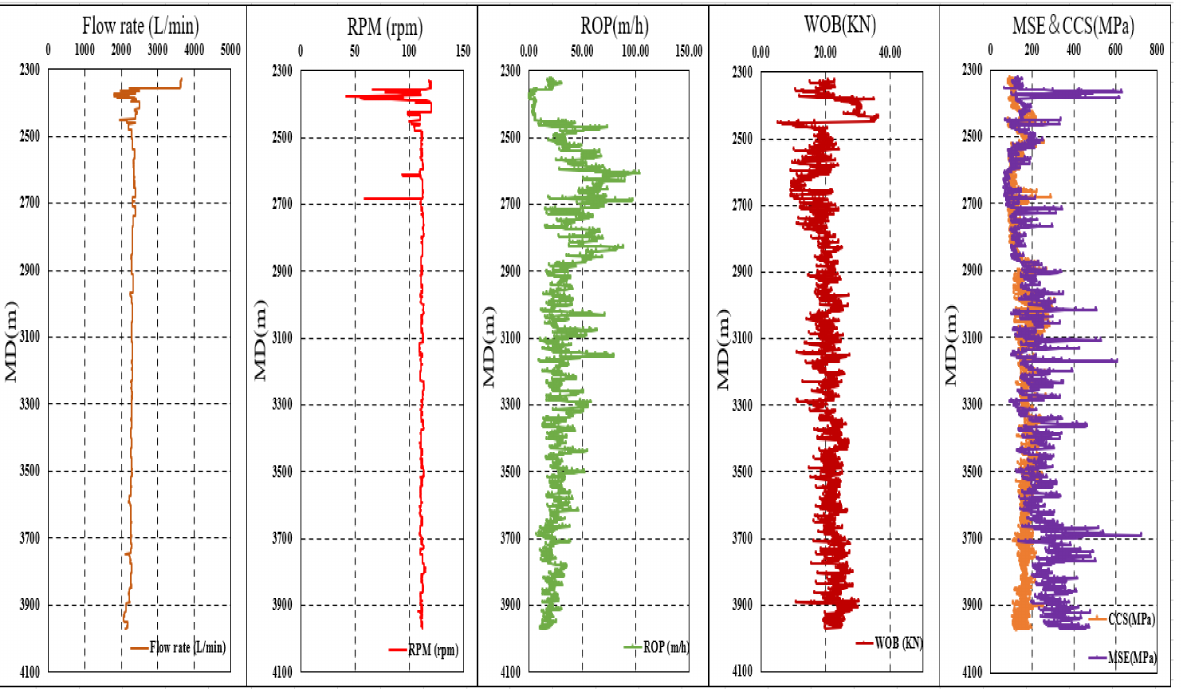
Figure 5. Mechanical-specific energy monitoring of compound percussion drilling in the Lufeng X